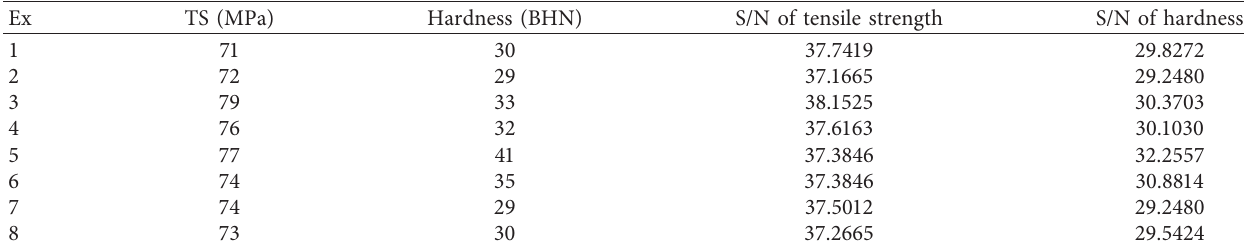
Figure 5: Taguchi optimization. Table 5: Experimental and S/N ratio